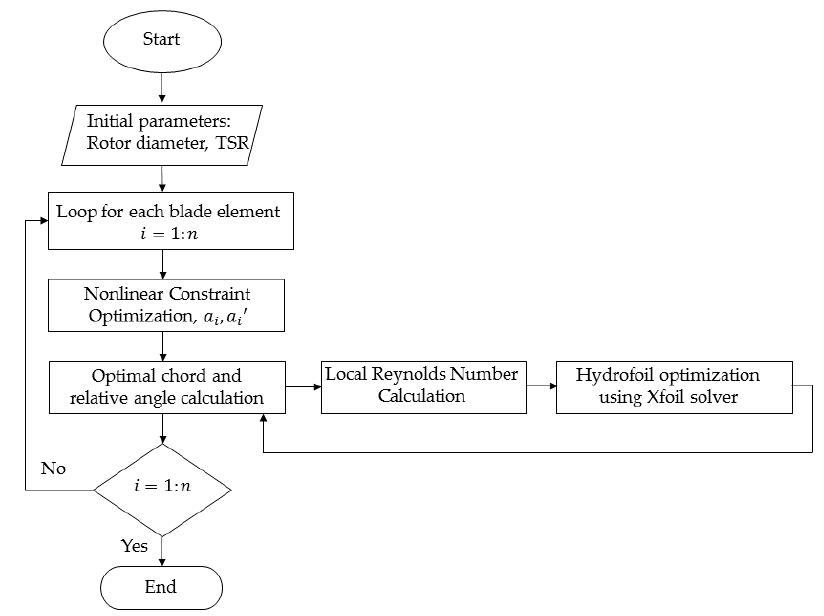
Figure 1. Rotor design flow chart.